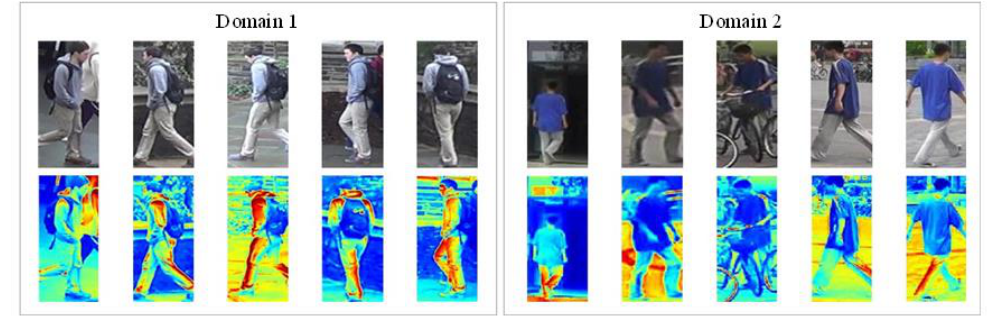
Figure 1. The sample images of person re-ID. The corresponding activation maps (AM) of the same pedestrians from two different domains as shown in the left- and right-hand sides,